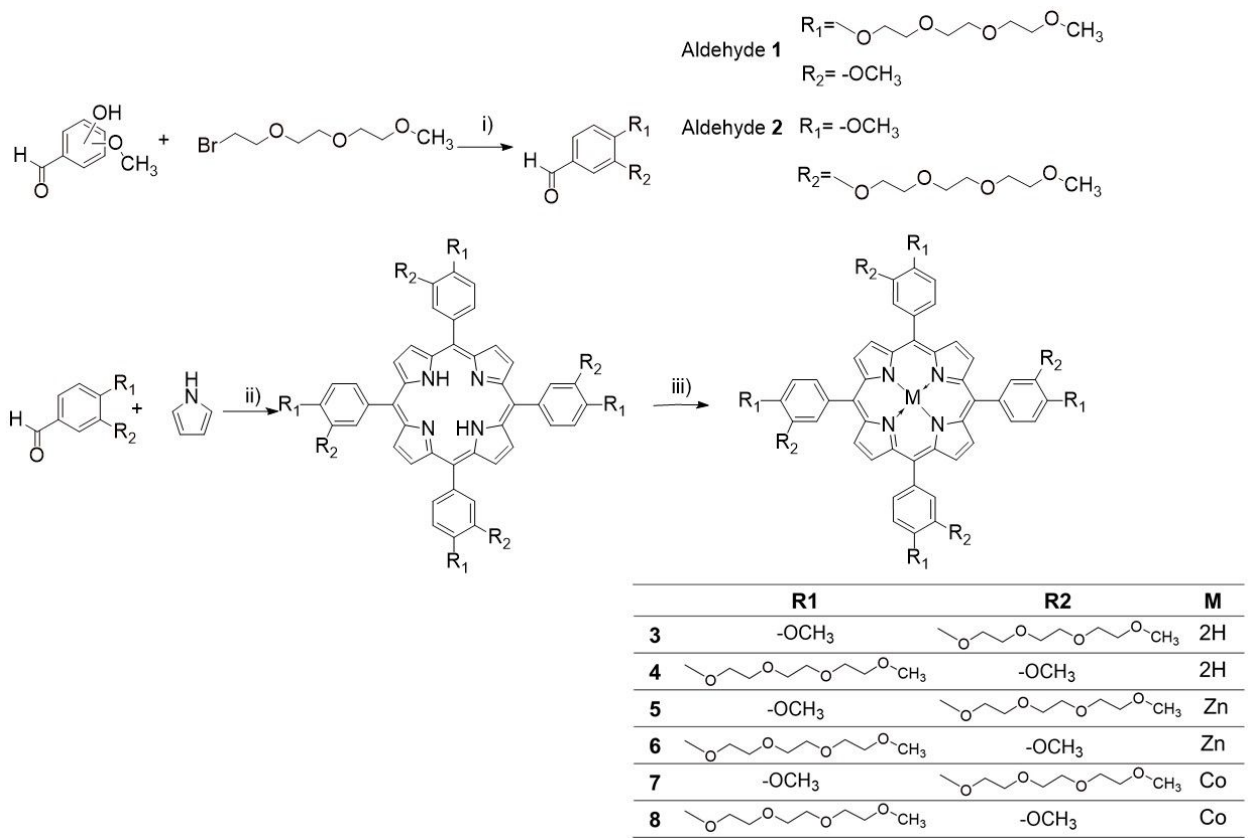
Figure 2. General synthetic scheme for the aldehyde substrates and porphyrins: (i) K 2 CO 3 , DMF, 80 °C, 24 h; (ii) propionic acid, 140 °C, 24 h; (iii) metal salt, DMF, 80 °C, 24 h.